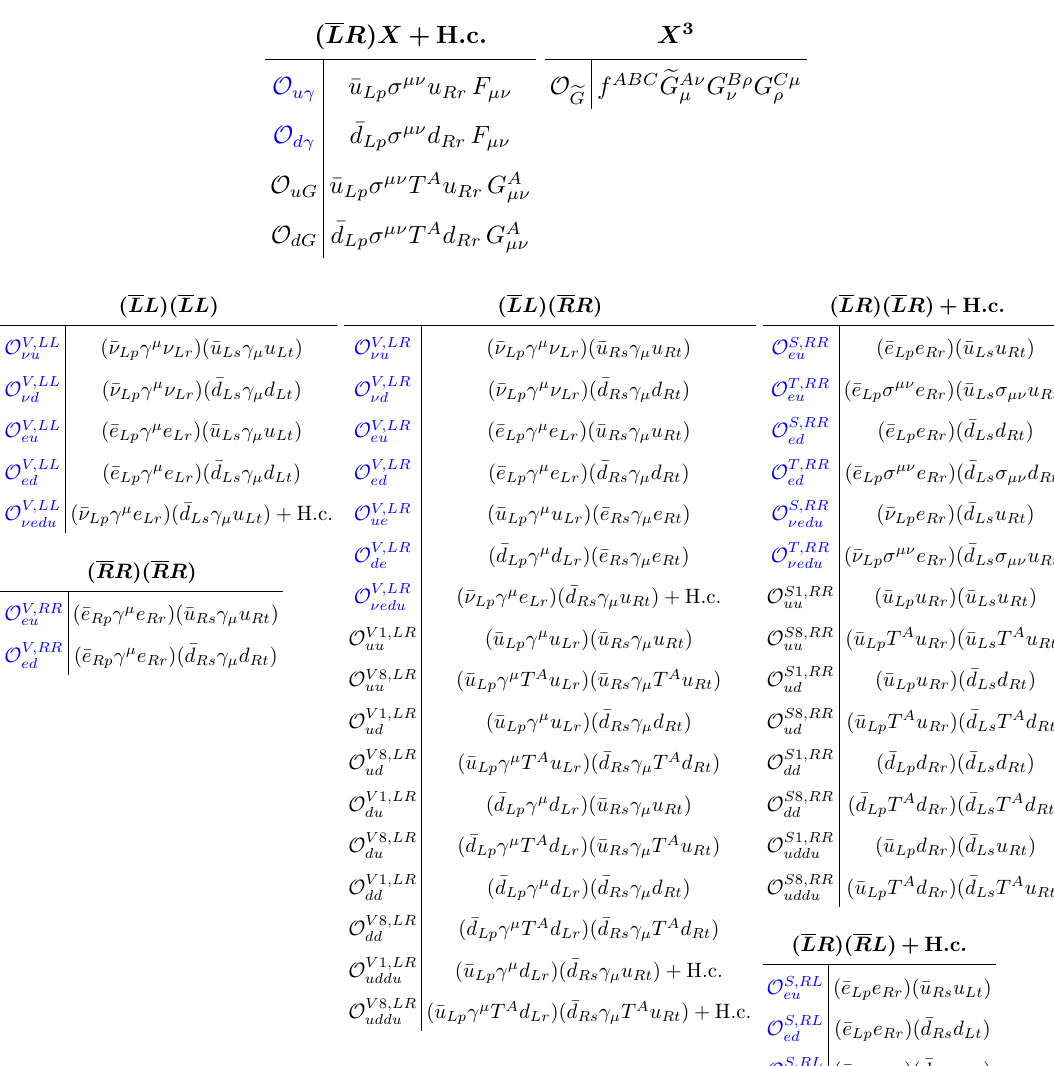
Table 1 . The B - and L -conserving operators of the LEFT of dimension five and six that contribute to CP-violating effects in the meson sector at leading order. Only the hadronic operators that contribute to the non-derivative meson interactions and the semi-leptonic operators that can be written as external sources (shown in blue) are